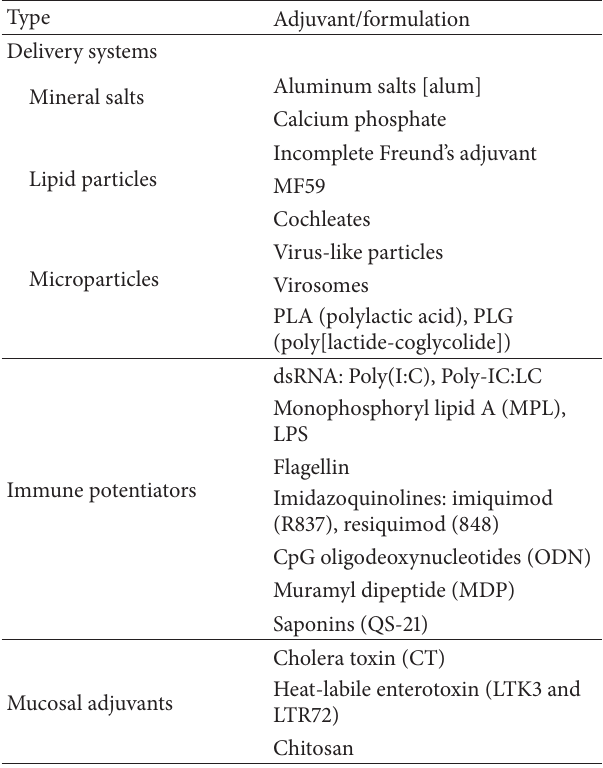
Table 1: Classification of